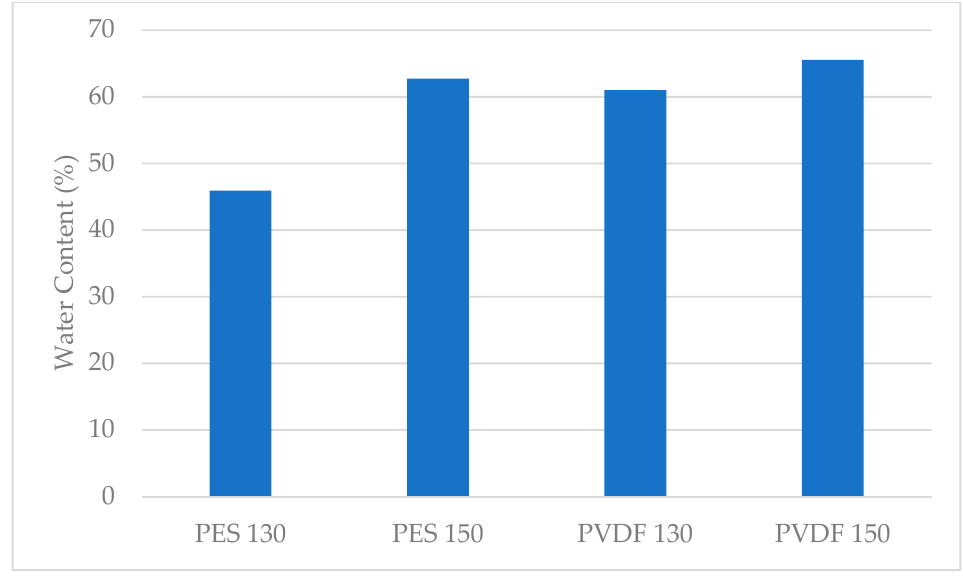
Figure 8. The water content of membranes. Table 2. Minimum pore diameters of the